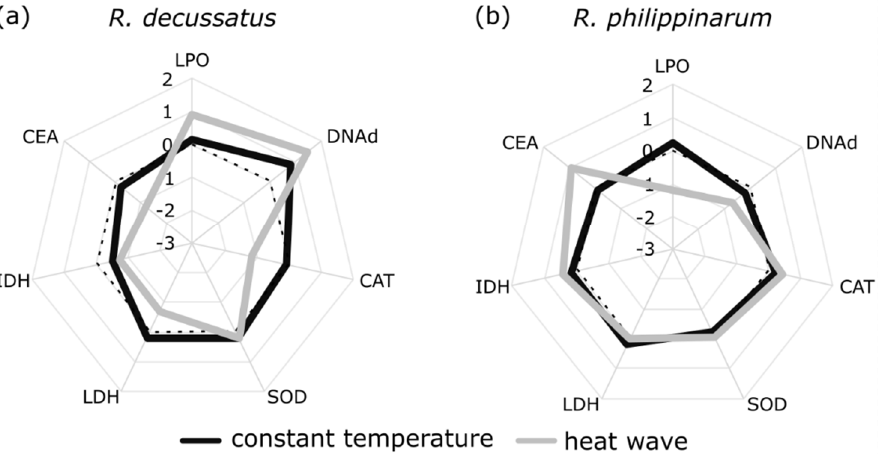
N and ( b ) PO 4 -P concentrations (mg L − 1 ) in the water at day 12. For clarity, jitter has been applied to the × = argument of